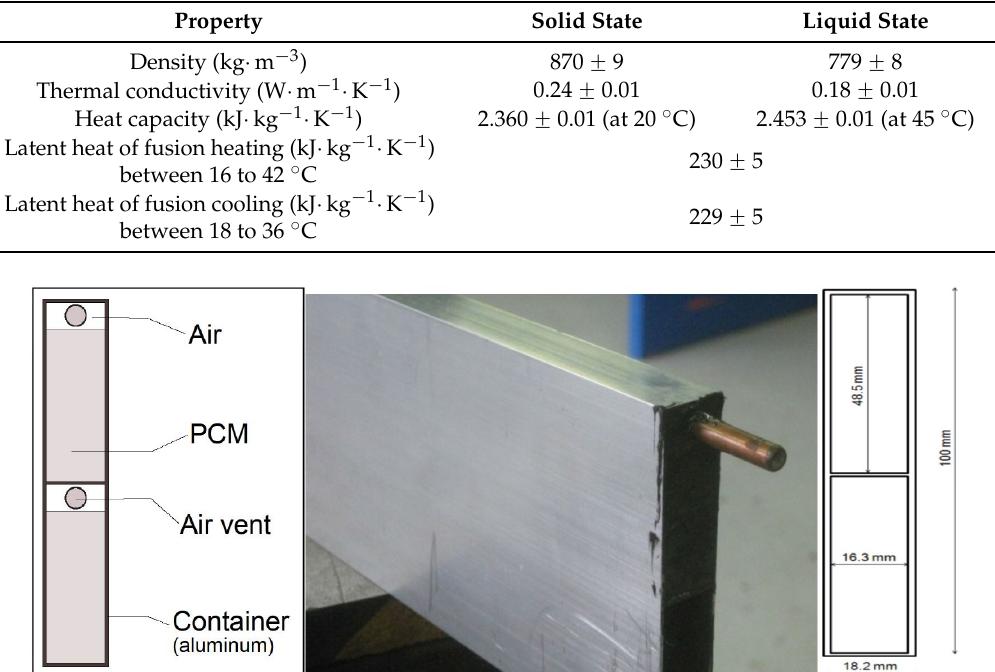
Table 1. Thermal properties of the material.